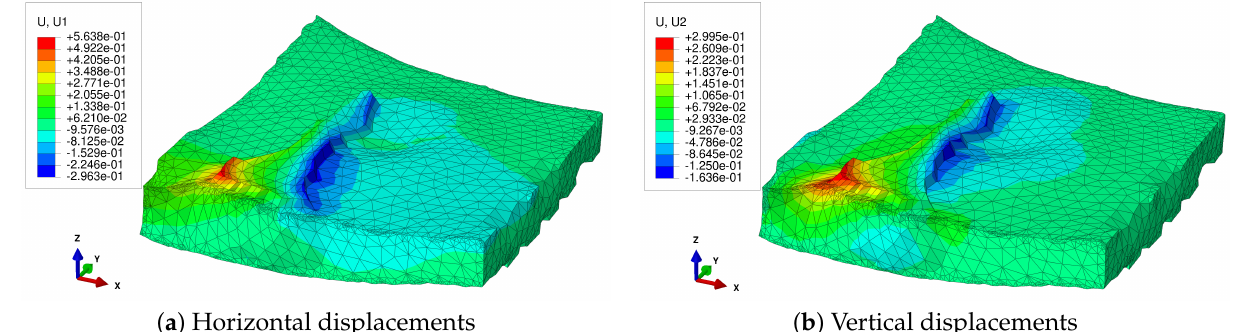
Figure 7. Maximum horizontal and vertical displacements for the Retina and ERM model—Recovered Patient, [mm].